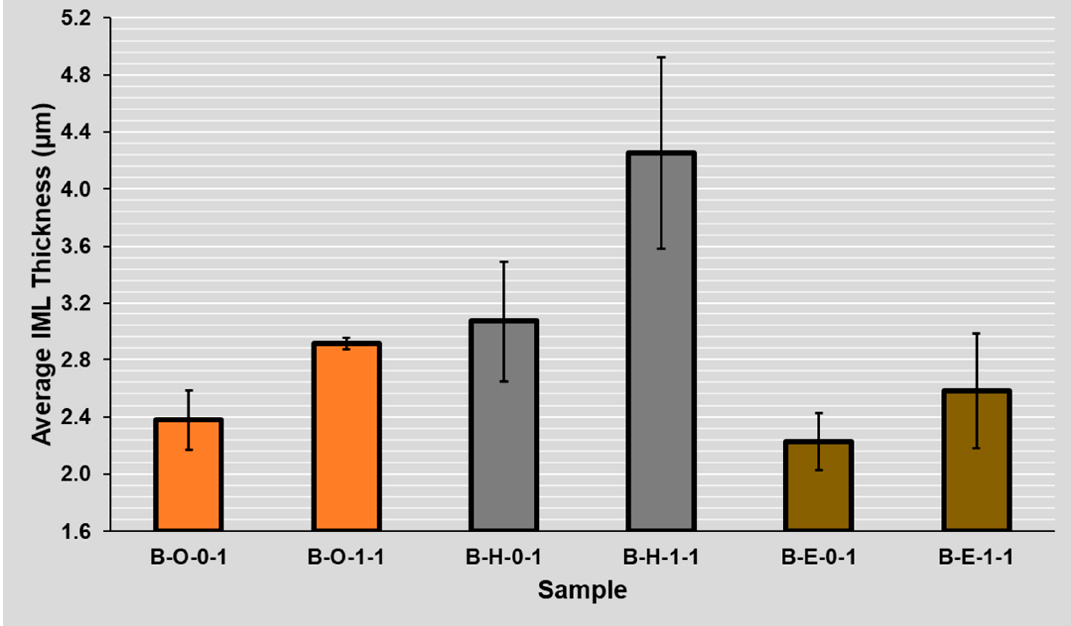
Figure 13. Flux type influence on the average IML thickness for samples with the B lack solder mask ( B lack/ W hite)—( O SP, H ASL, E NIG)—(ROL 0 , ROL 1 )—( 1 , 2 reflows).